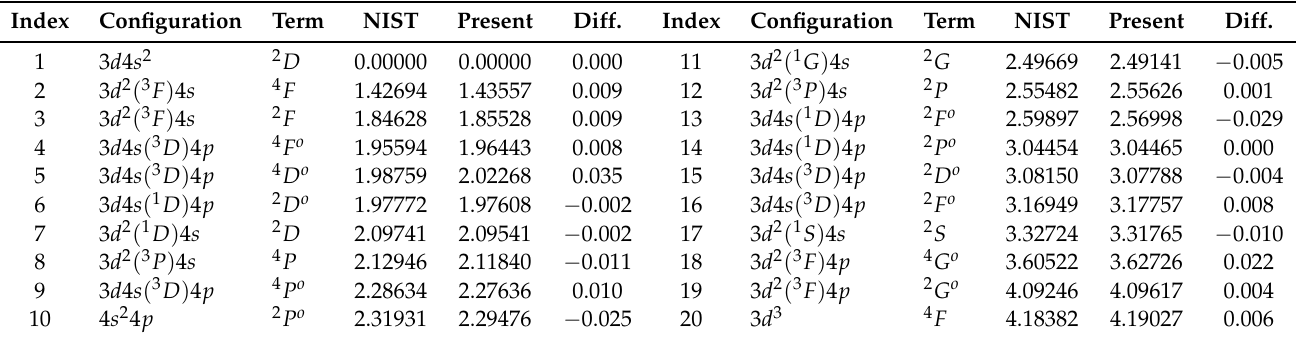
Table 1. The Sc I target state excitation energies (in eV).